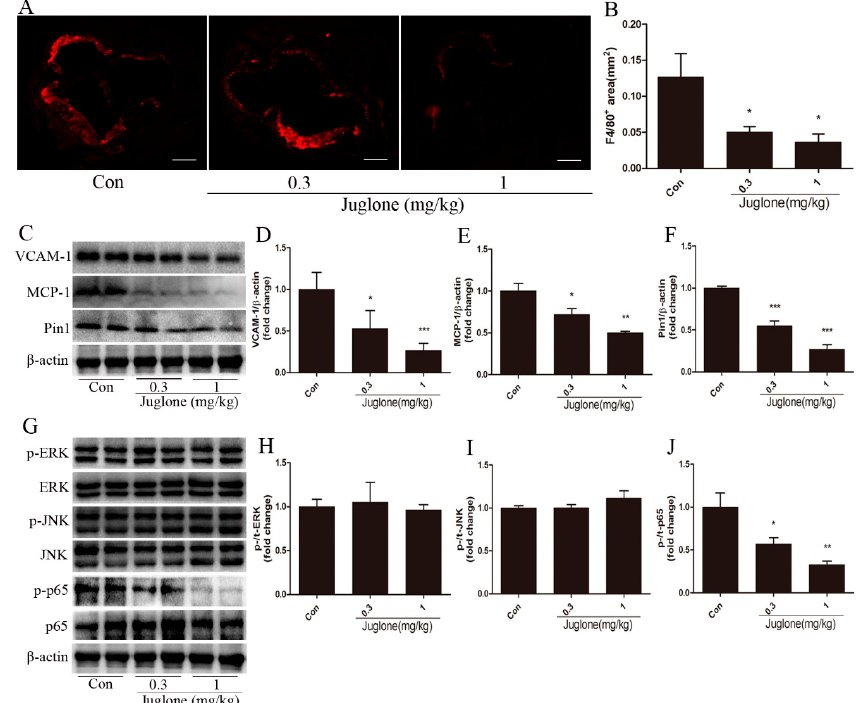
Figure 2. Pin1 impacts vascular inflammation and signaling pathways in the aortas of ApoE − / − mice. At ages of 18 weeks, ApoE − / − mice were sacrificed, and aortas were retrieved. The levels of macrophages accumulation in atherosclerotic lesions were examined by immunohistochemical staining of F4/80 ( A ) and quantified ( B ) ( n = 7, scale bar = 50 μ m); ( C – F ) Aortic tissues from indicated mice were subjected to Western blot for the detection of VCAM-1 ( D ), MCP-1 ( E ), and Pin1 ( F ) expression, normalized by levels of β -actin ( n = 4), and the representative bands are shown ( C ); ( G – J ) Signal transduction in aortas was examined by Western blot: ( H ) for ERK, ( I ) for JNK, and ( J ) for NF- κ B ( n = 4), and the representative bands are shown ( G ). * p < 0.05, ** p < 0.01, *** p < 0.001 vs. the control group.